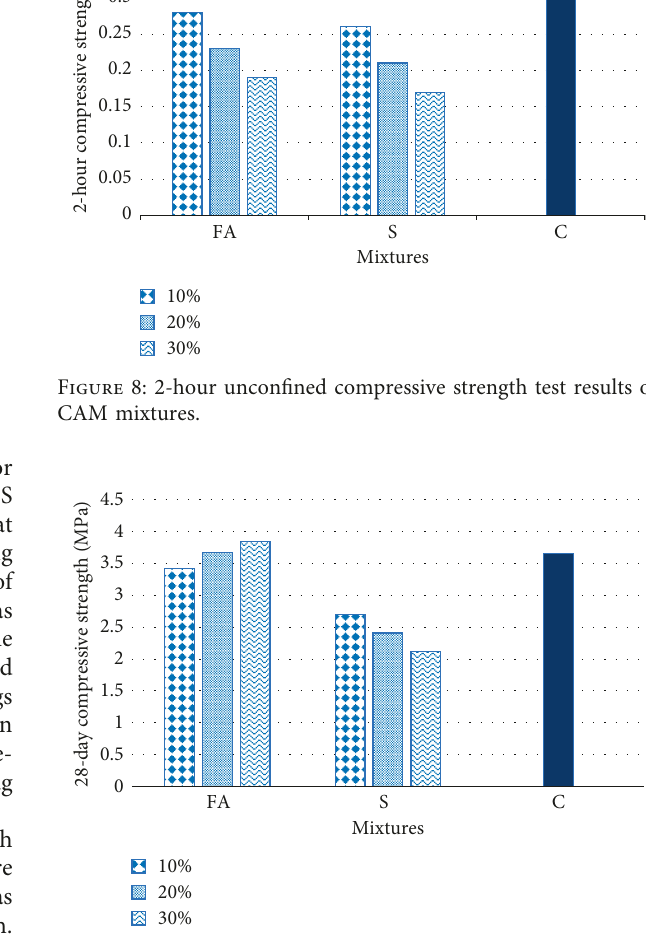
Figure 9: 28-day unconfined compressive strength test results of CAM